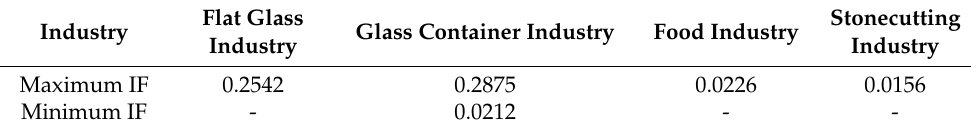
Table 12. Upper and lower limits of industry factors.